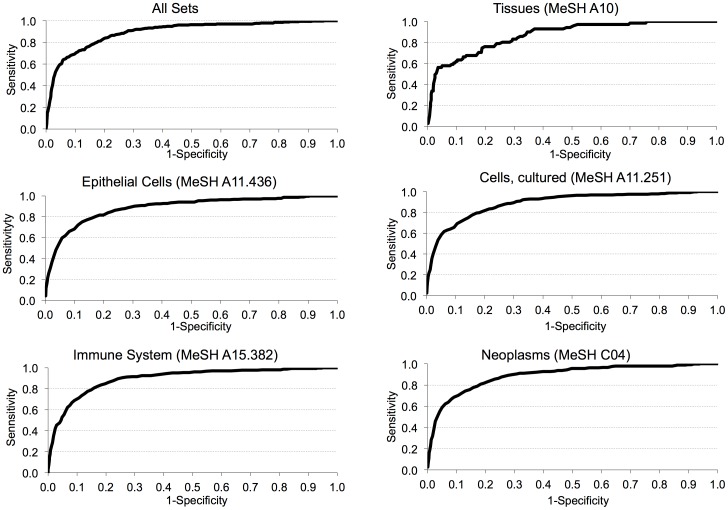
Receiver Operator Characteristic (ROC) curve of the simple threshold based classifier.The receiver operator characteristic (ROC) curve of a simple threshold classifier over all datasets and some MeSH categories. The housekeeping gene set by Eisenberg et al. [22] is used as the ground truth. The simple threshold classifier classifies all the genes with CV values below a threshold as housekeeping genes. By using different CV thresholds the stringency of the classifier can be varied and the ROC curve can be plotted accordingly. Sensitivity is the ratio of correctly classified ground truth genes over all ground truth genes and specificity is the ratio of correctly identified non-housekeeping genes over all non-housekeeping genes. Complete set of MeSH classified RO-curves are given in hyperlinked Supporting Information S3 spreadsheet.